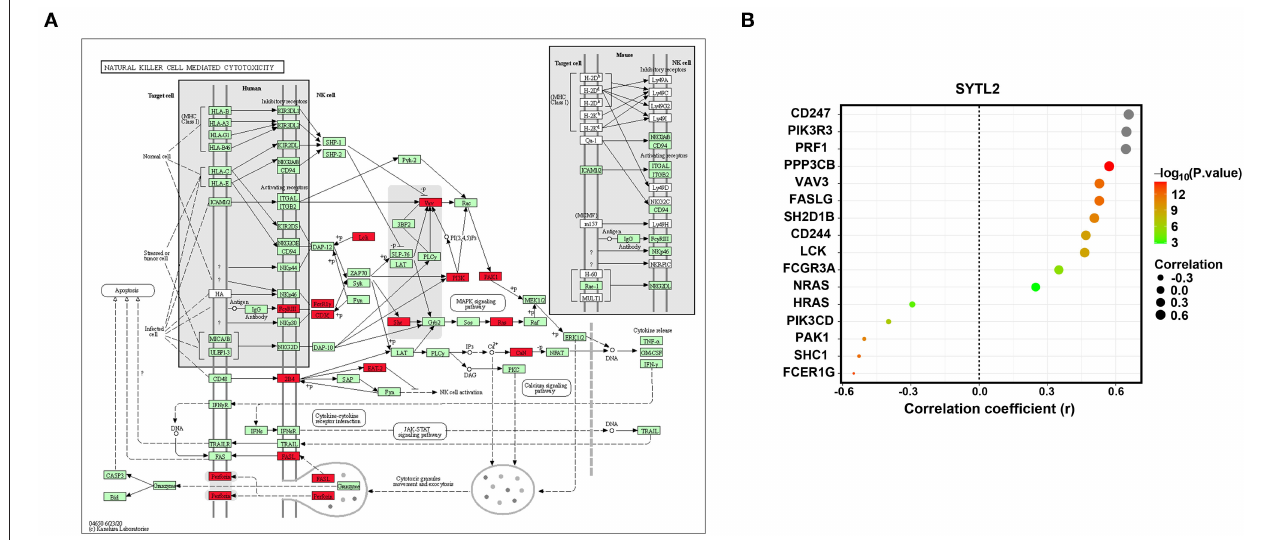
FIGURE 8 | Association between SYTL2 and the NK cell-mediated cytotoxicity signaling pathway. (A) Regulation network of the NK cell-mediated cytotoxicity signaling pathway as obtained from the KEGG database. The red square indicates that the gene was significantly correlated with SYTL2 ( P < 0.05). (B) Correlation between the expression level of SYTL2 and the genes in the NK cell-mediated cytotoxicity signaling